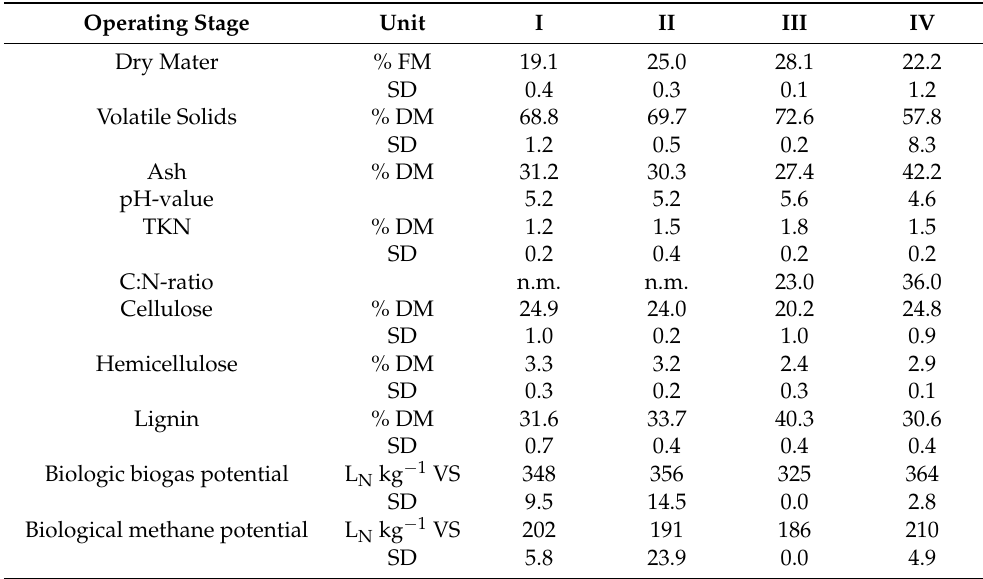
Table 2. Characterization of the feeding